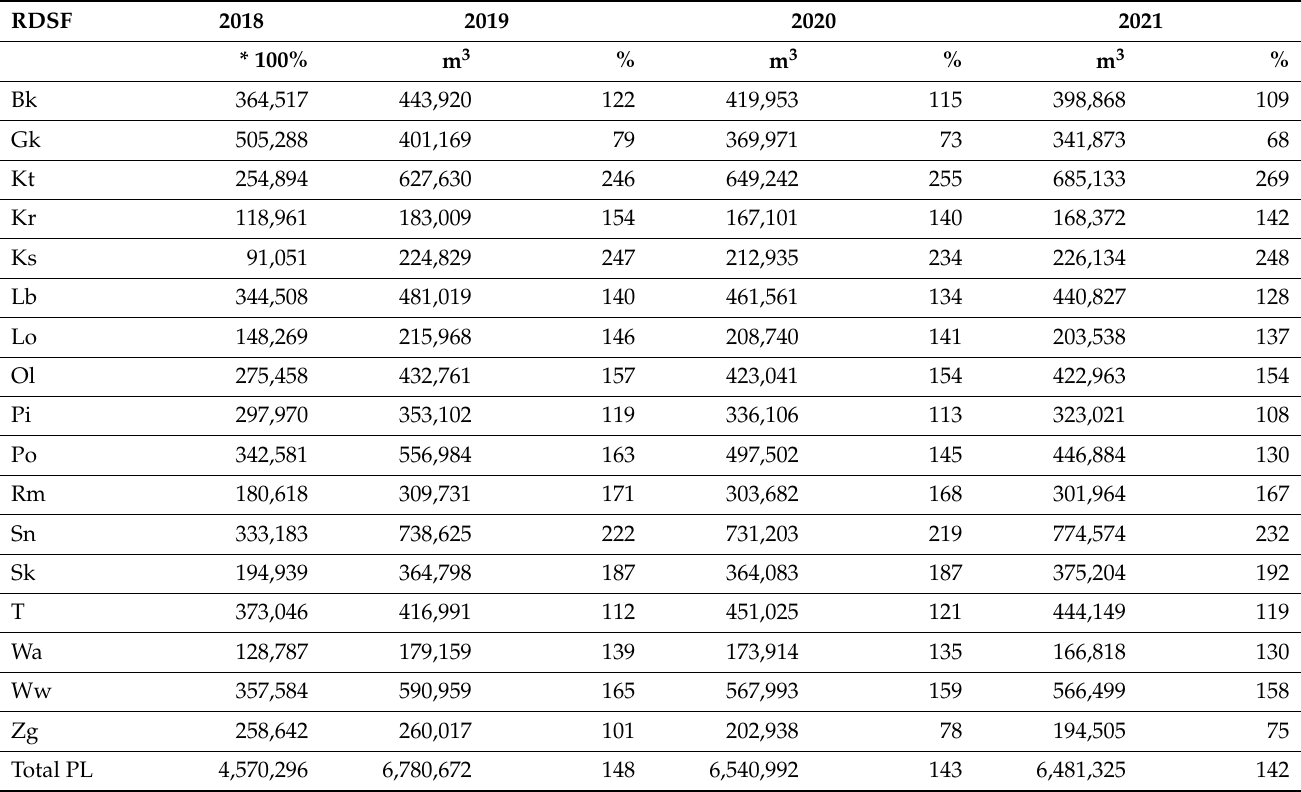
Table 4. Forest biomass resources by directorate (RDSF) in Poland.